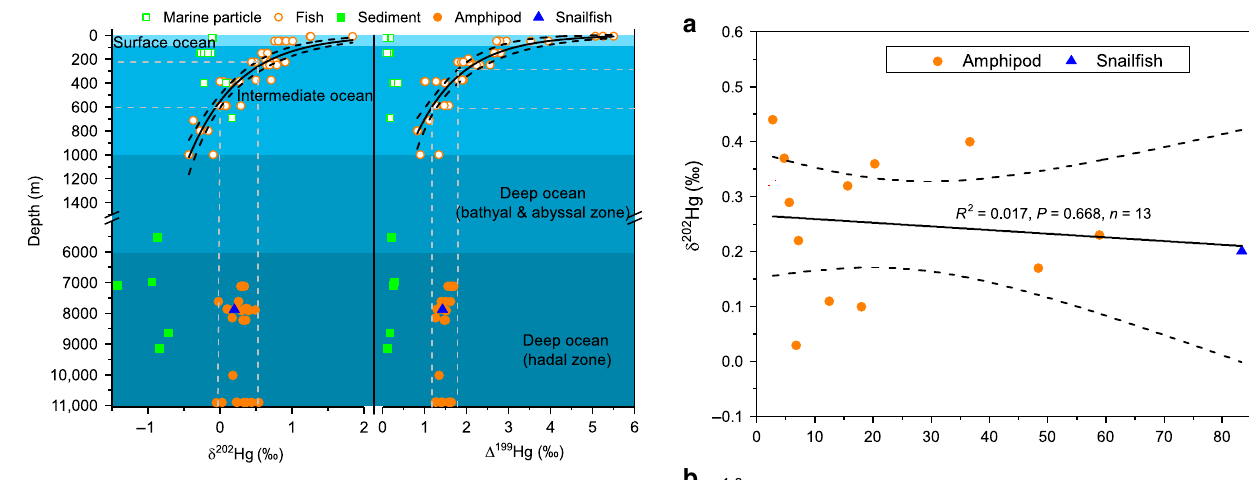
Fig. 2 Depth pro fi les of δ 202 Hg and Δ 199 Hg in trench samples. Samples measured in this study are marked with fi lled symbols. Δ 201 Hg (not shown) shows similar vertical trend as Δ 199 Hg. Also shown are the marine particles and fi shes (open symbols) from North Paci fi c Subtropical Gyre 16,32 , and the best- fi tted regression curves of water depths with δ 202 Hg (R 2 = 0.812, p = 1.11E-16, n = 37 samples) and Δ 199 Hg (R 2 = 0.749, p = 1.32E-14, n = 37 samples) for fi shes. The dashed lines show the water depths predicted by the regression curves using the δ 202 Hg and Δ 199 Hg values of trench fauna. The typical analytic uncertainty of our fauna (sediment) samples was 0.08 ‰ (0.08 ‰ , two standard deviation) for δ 202 Hg and 0.10 ‰ (0.04 ‰ , two standard deviation) for Δ 199 Hg.